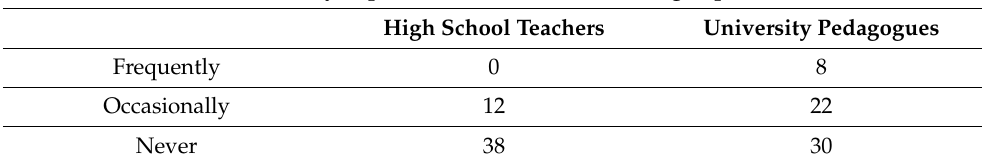
Table 5. Teachers’ and pedagogues’ prior experience with online